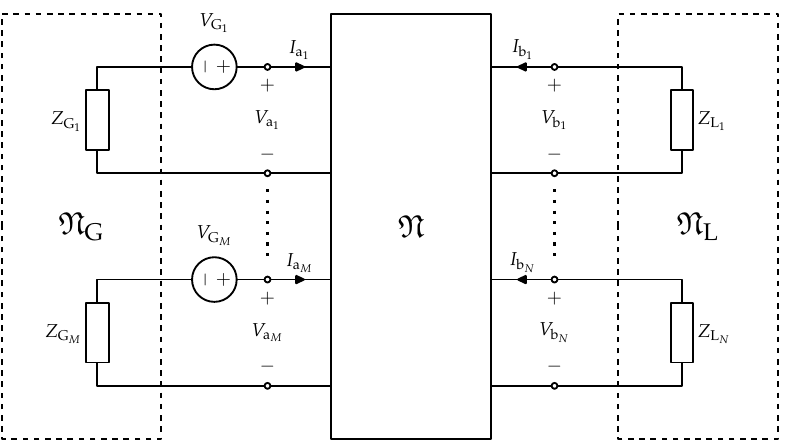
Figure 1. Schematic representation of a multiple-input-multiple-output (MIMO) wireless power transfer (WPT)